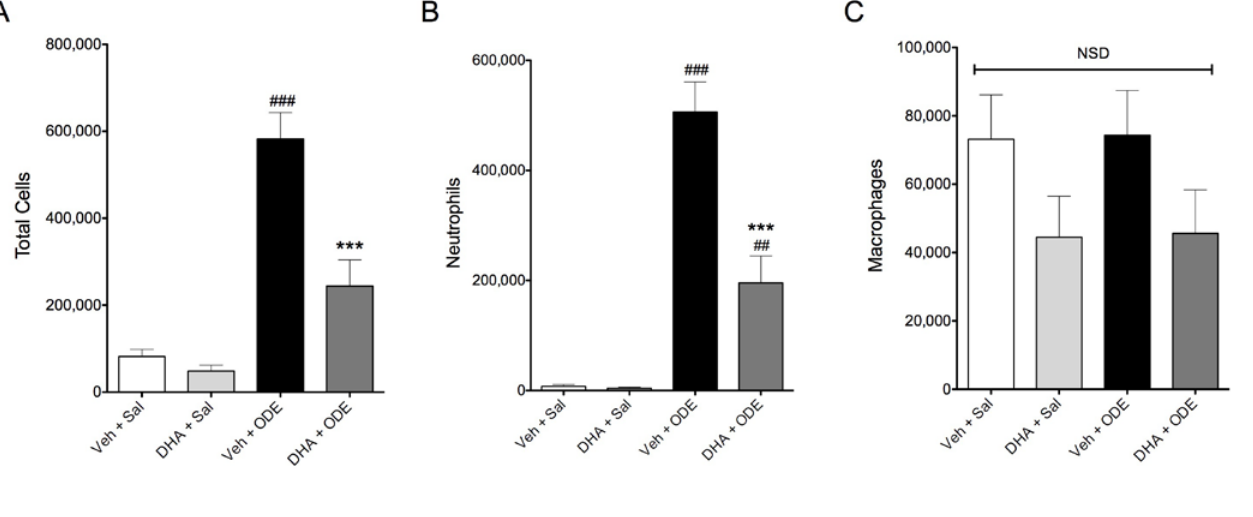
Figure 6. Effect of DHA supplementation on cell influx into the airways of mice receiving a single intranasal ODE instillation. C57BL/6 mice were given daily 0 or 2 mg DHA supplementation via oral gavage for seven consecutive days prior to a single intranasal instillation of 50 μL 12.5% ODE or saline and BALF was obtained 5 h post-treatment. Total ( A ); neutrophil ( B ); and macrophage ( C ) cell numbers were enumerated. ## p ≤ 0.01